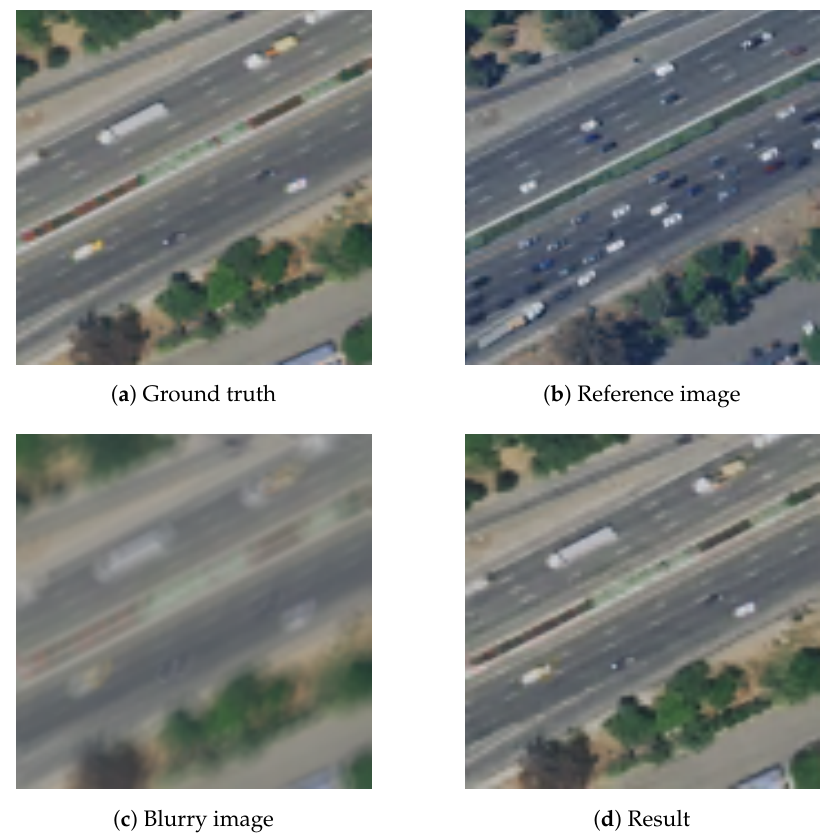
Figure 9. Algorithmic restoration result when there are extra textures in the reference image.